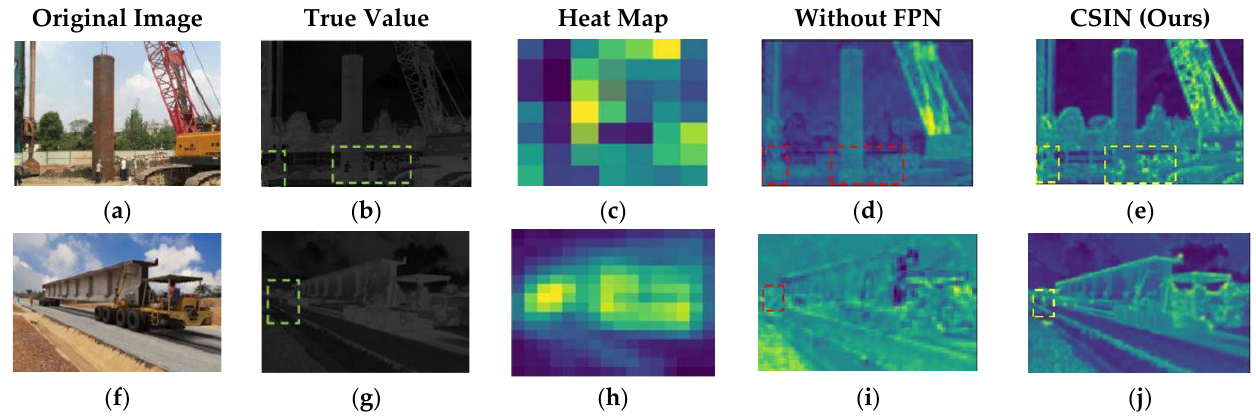
Figure 8. Visualization of the convolutional feature map obtained by channel-dimension averaging. (The sources of the identifiable images in Figure 5 are shown in the Supplementary